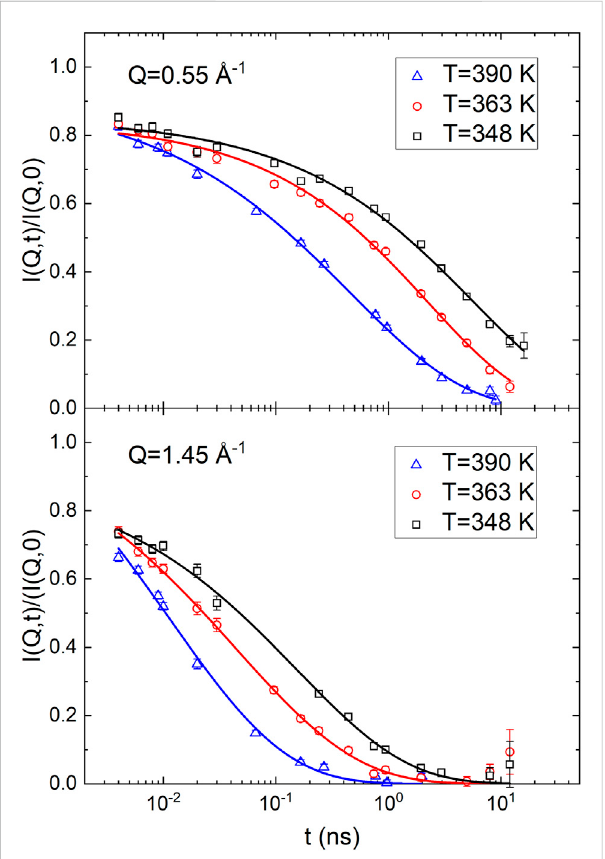
FIGURE 2 The normalized ISF of sample 1a, dP (EO) 7.5 LiTFSI, measured at NCNR. The continuous lines are fi t using Eq. 15. Error bars represent standard deviation.